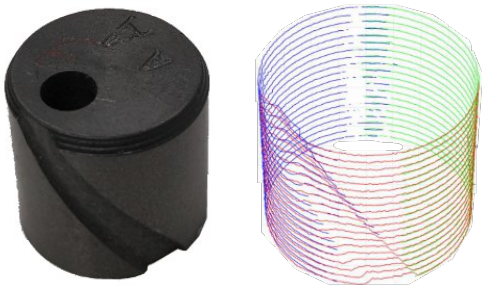
Figure 13: 13 mm diameter steel shaft with black oxidation and helical groove – 20 sections with 0.68 mm between sections.